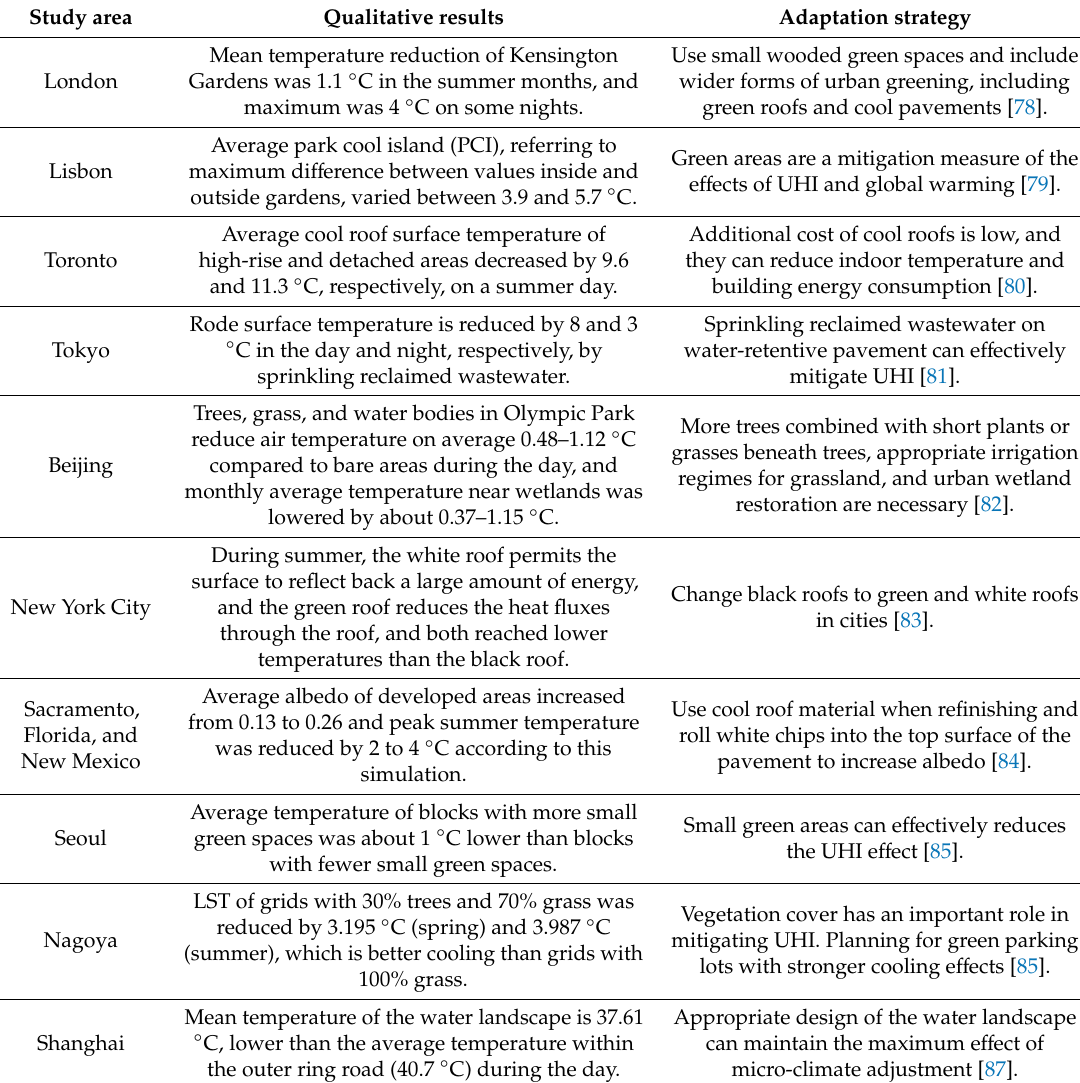
Table 3. Adaptation strategies for cities proposed by relevant